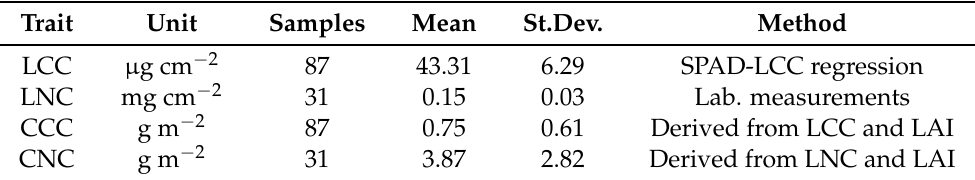
Table 1. List of crop traits used in this study, units, number of available samples, average, standard deviation and the method used to derive